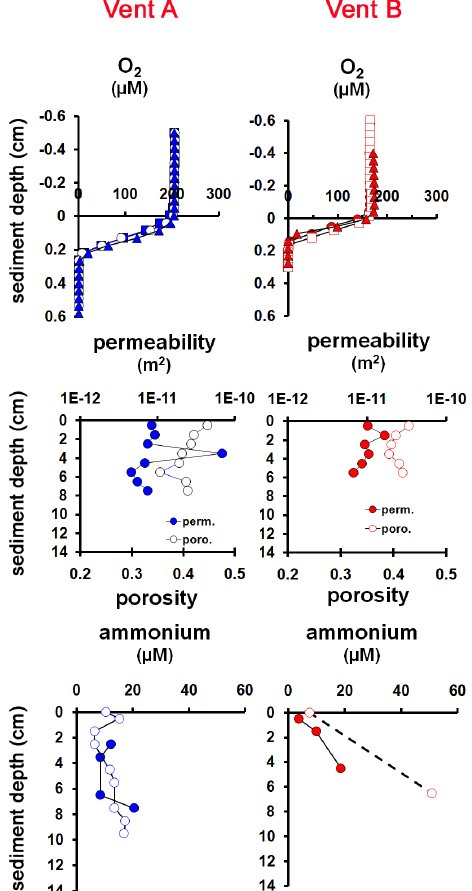
Fig. 3a. Biogeochemical profiles of the June sampling at Brian Seep: oxygen (3 replicates), permeability, porosity, and ammonium. At 60cm, the ammonium profile is dashed, because of low reliabil- ity given by the limited amount of data points over depth. Cores were sampled close to gas vents: Vent A (blue) and B